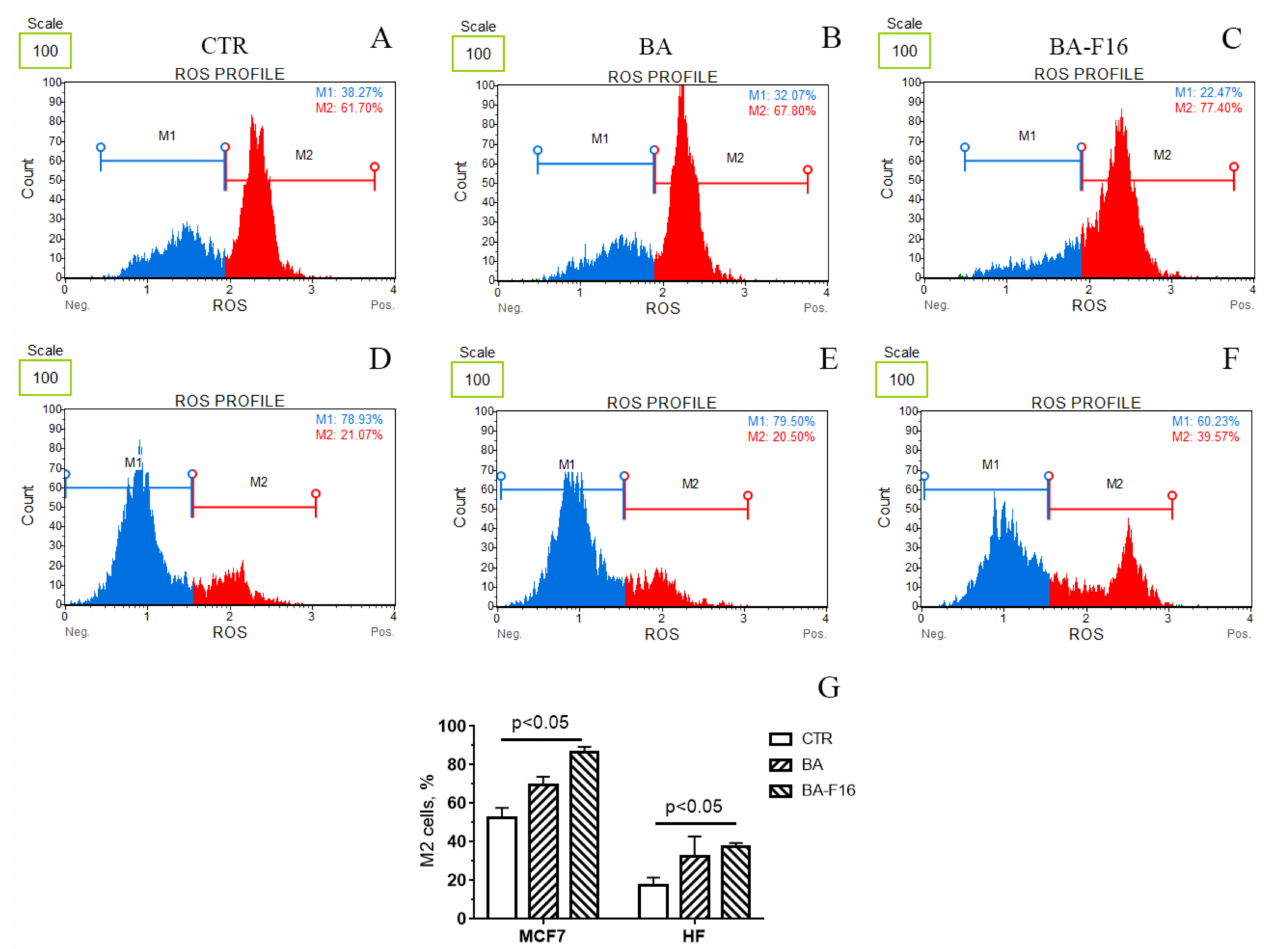
Figure 5. Effect of 5 µ M of BA and 1 µ M of BA–F16 on the production of reactive oxygen species by MCF-7 and HF cells. ( A – F ) Typical distribution diagrams of MCF-7 ( A – C ) and HF ( D – F ) cell populations in the presence of BA ( B , E ) and BA–F16 ( C , F ). ( G ) Calculation of ROS-positive cells (%) in experimental groups. Means ± SD are shown ( n = 4–5).